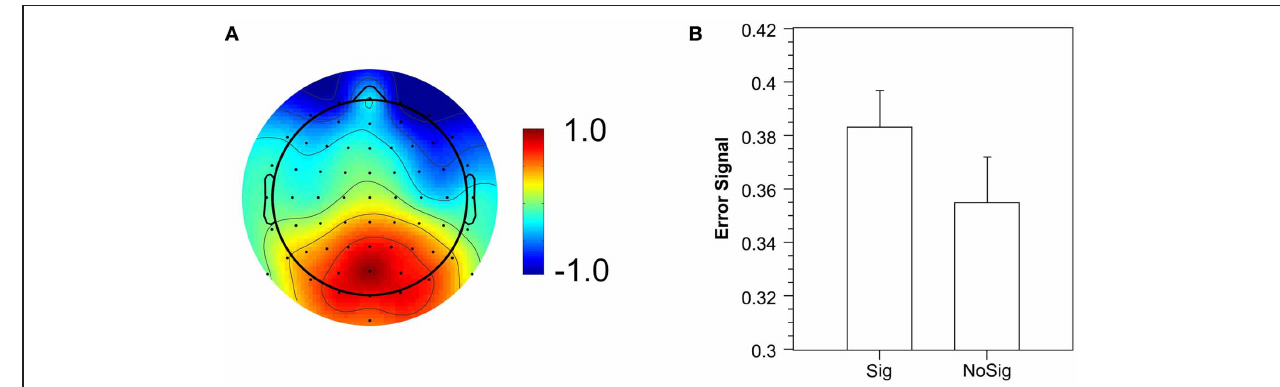
FIGURE 6 | Error signal extracted by single-trial analysis. (A) Spatial distribution of the error signal as illustrated by normalized coupling coefficients. (B) Mean error signal for signaled (Sig) and unsignaled (NoSig) errors.